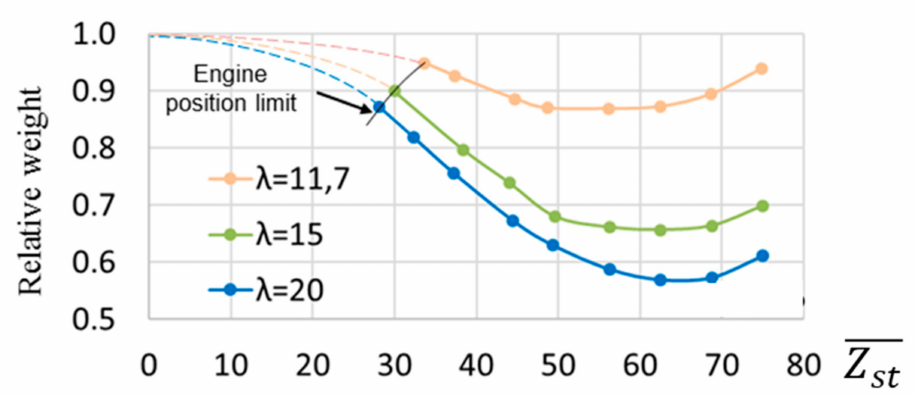
Figure 18. Dependencies of relative weight wing with strut from parameter Z st .